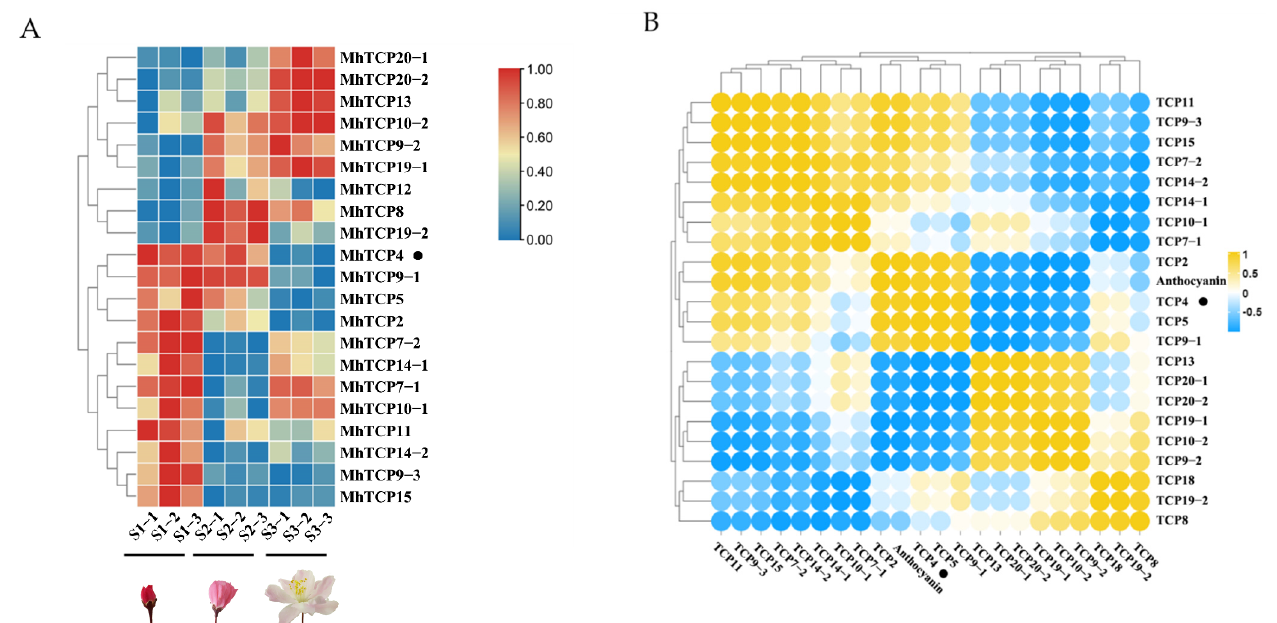
Figure 1. Expression and correlation analysis of MhTCP s in Malus halliana . ( A ) Heat map of the expression of MhTCP s in the petals at three stages. S1, small bud stage; S2, initial-flowering stage; and S3, late-flowering stage. MhTCP4 is marked by the black dot. ( B ) Heat map representing the correlation between MhTCP s expression and the anthocyanin content in the different development stages of petals. Yellow dot represents a positive correlation, and the blue dot represents a negative correlation. MhTCP4 is marked by the black dot.